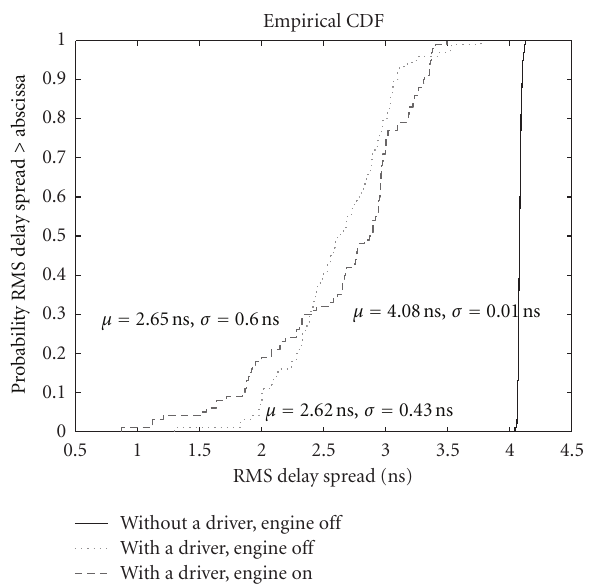
Figure 13: CDFs of the measured RMS delay spreads for Rx4 (OLOS) in the UWB band measurements in all three scenarios.